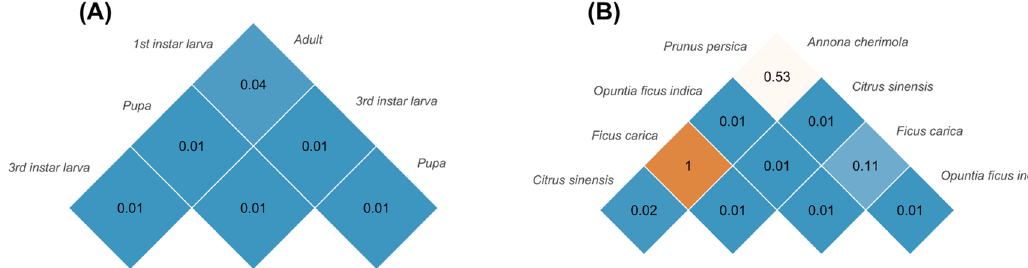
Fig 2. Multiple comparison procedure through PERMANOVA. (A) different life stages of C . capitata ; (B) larvae of C . capitata feeding on different host plants. Bonferroni-corrected P values are reported for each comparison.